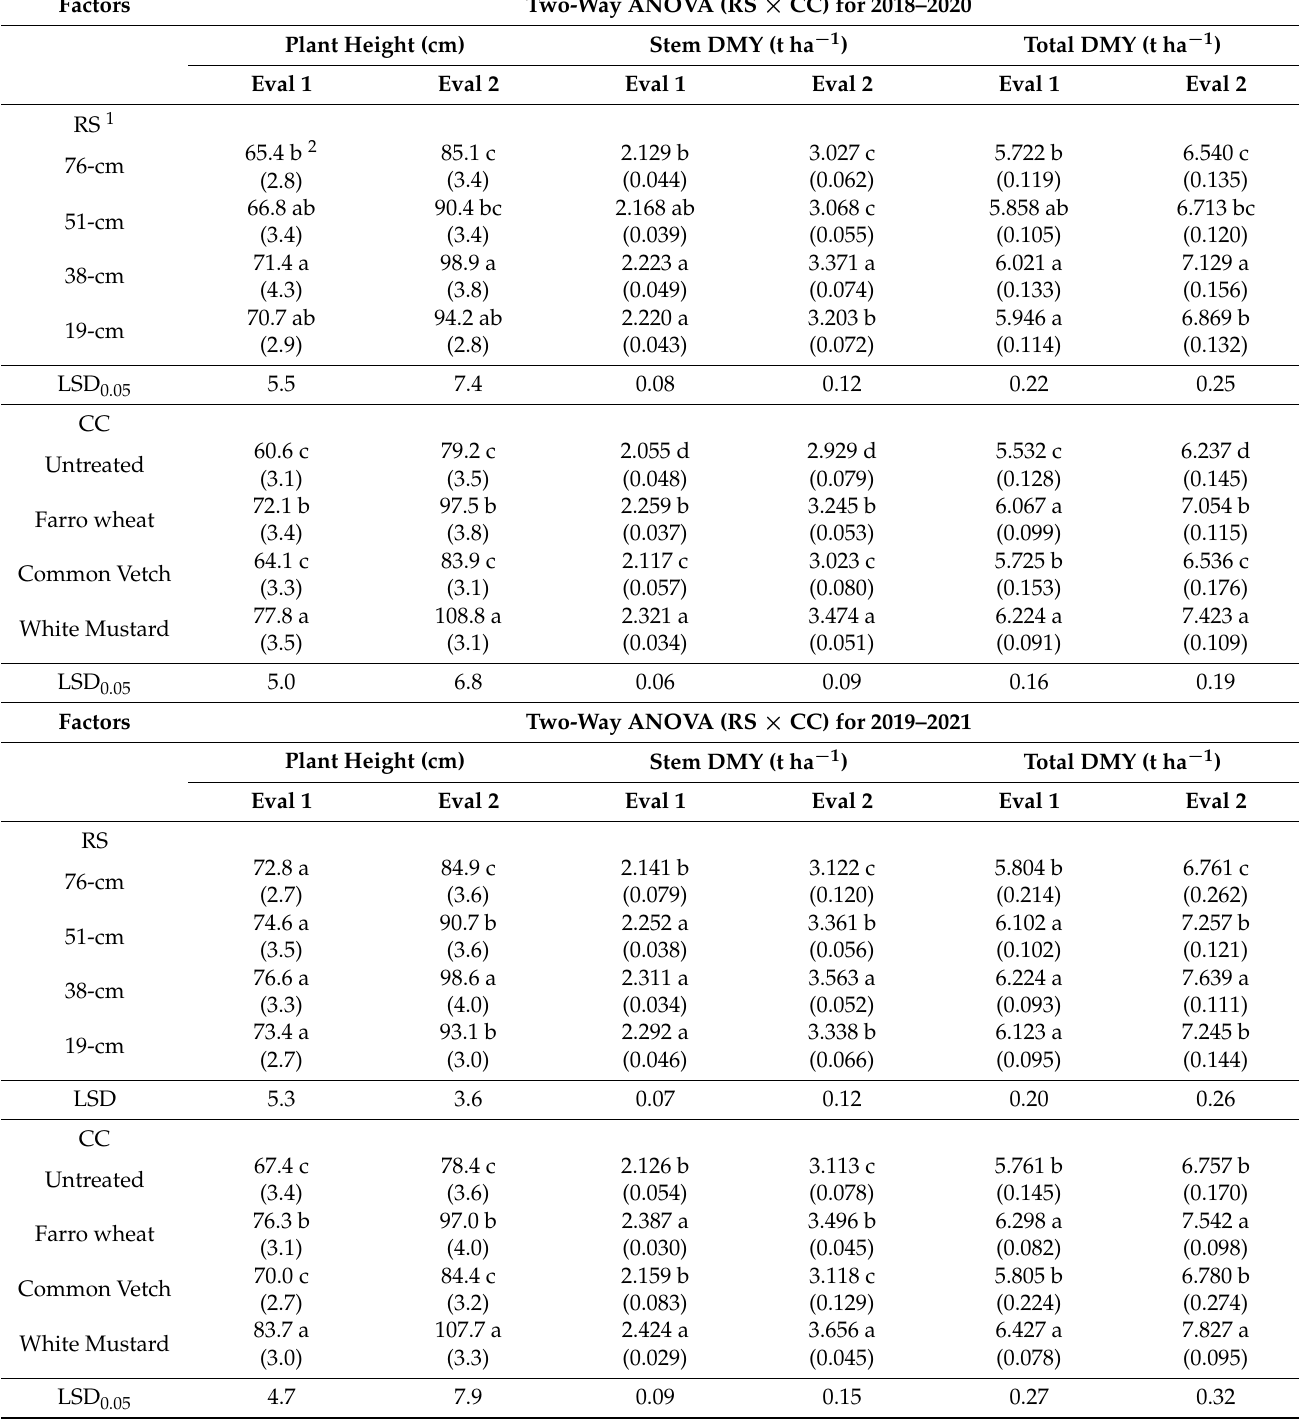
Table 6. The effects of sulla row spacing and cover crops on sulla plant height (cm), stem DMY (t ha − 1 ), and total DMY (t ha − 1 ) in the first year of sulla growth in the 2018–2020 and 2019–2021 growing cycles. Data were analyzed separately for each growing